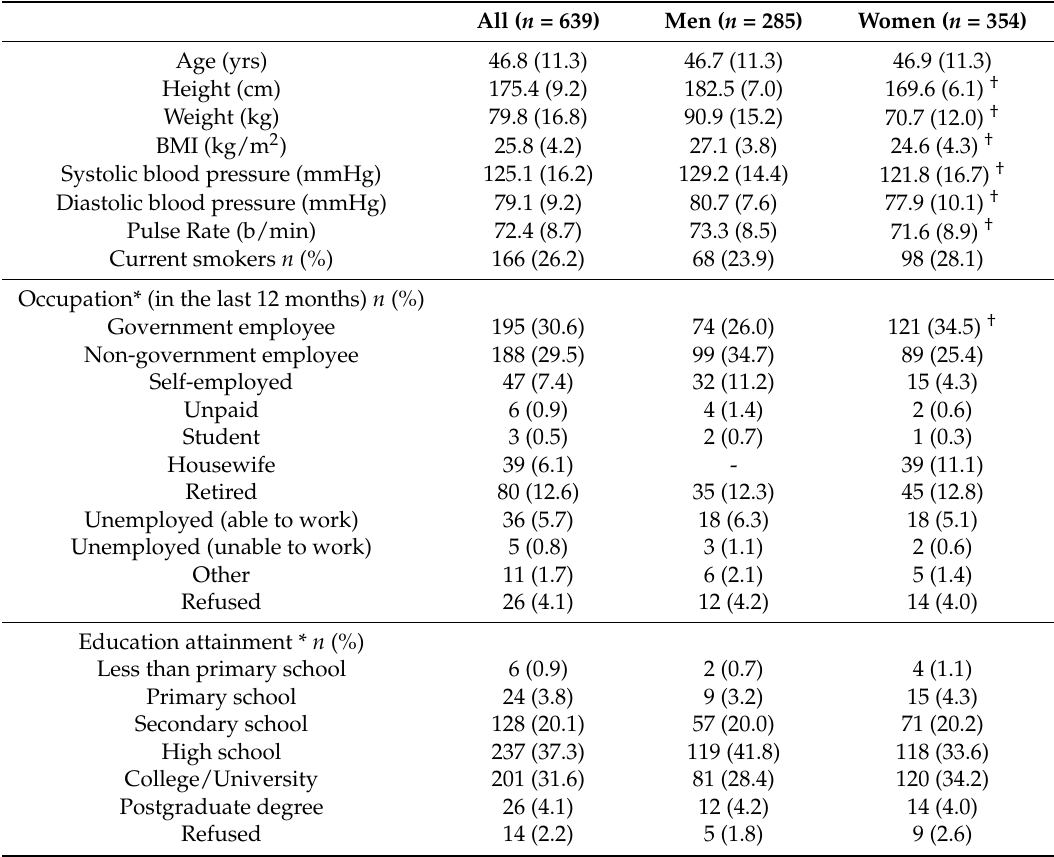
Table 1. Characteristics of the